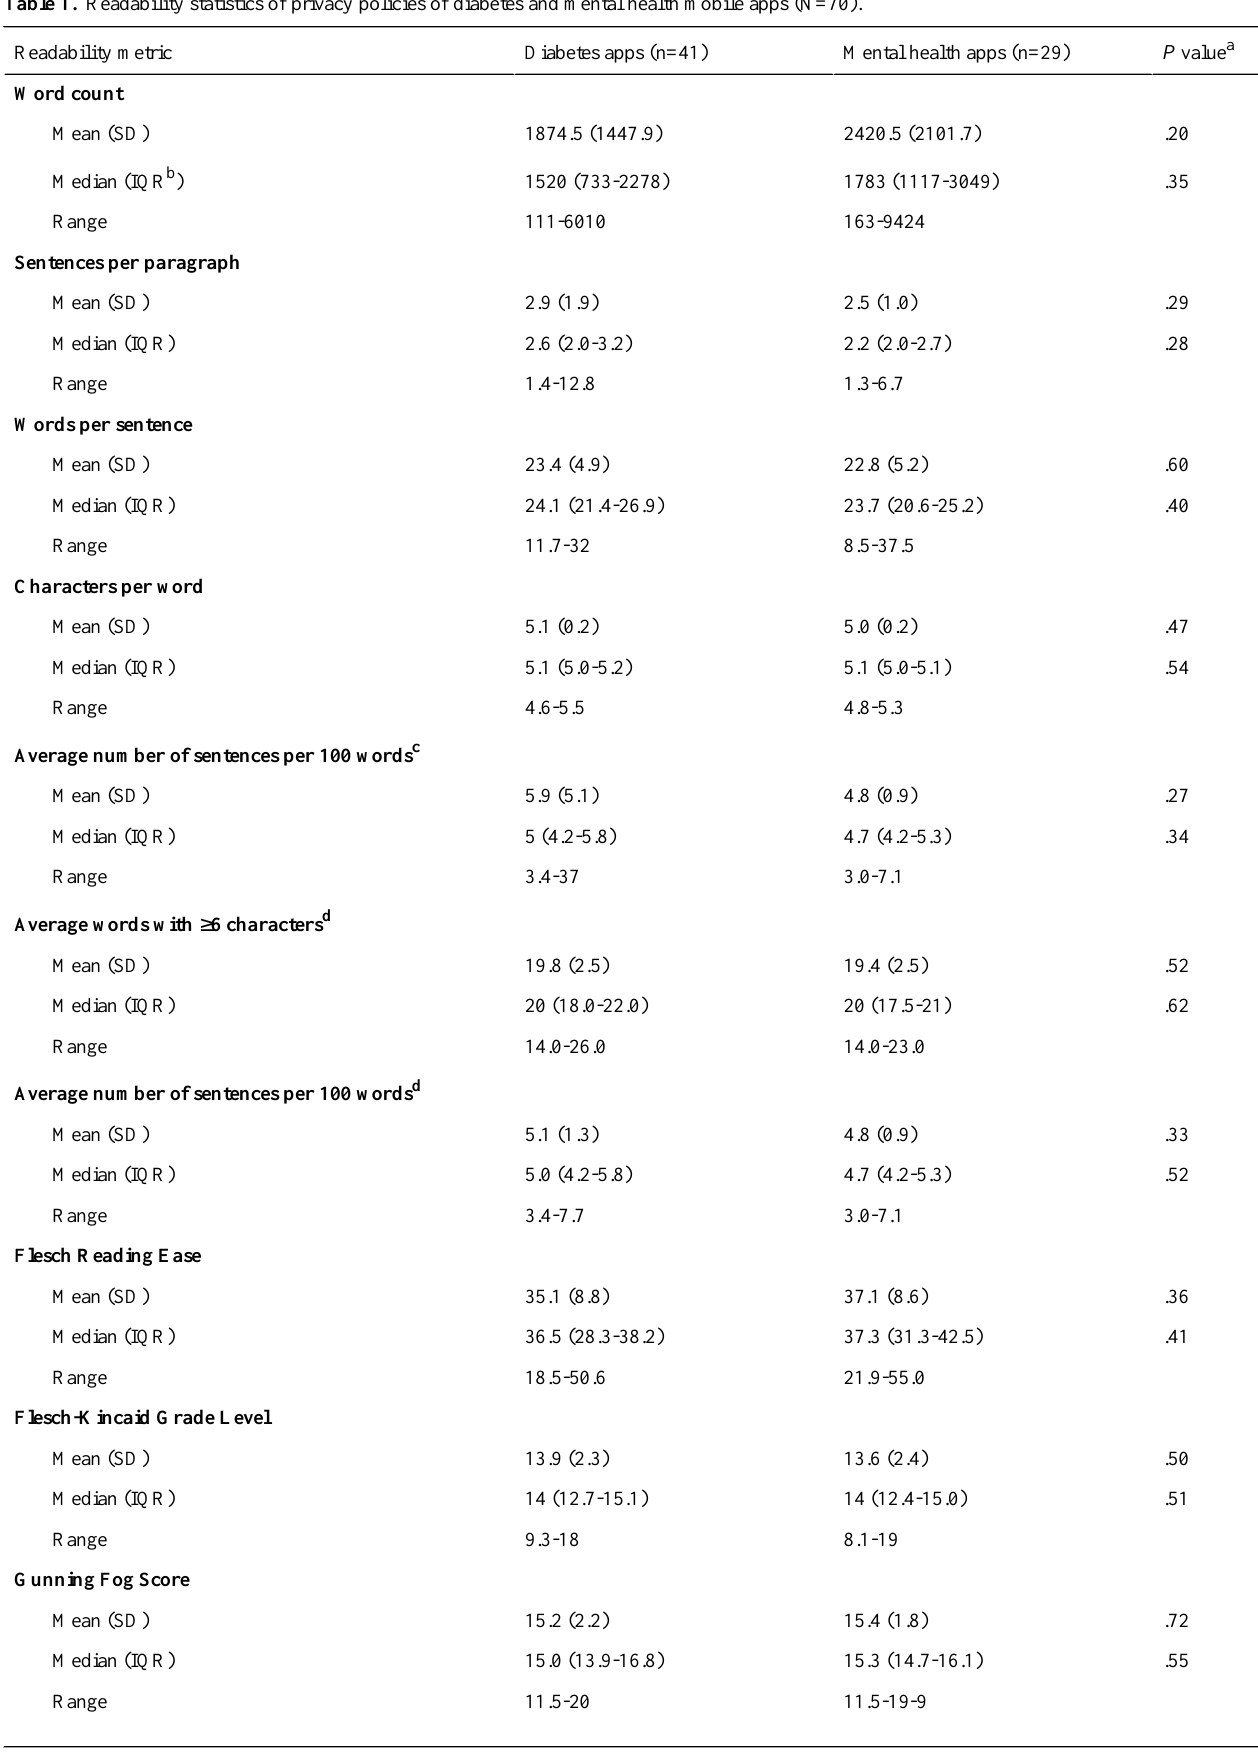
Table 1. Readability statistics of privacy policies of diabetes and mental health mobile apps